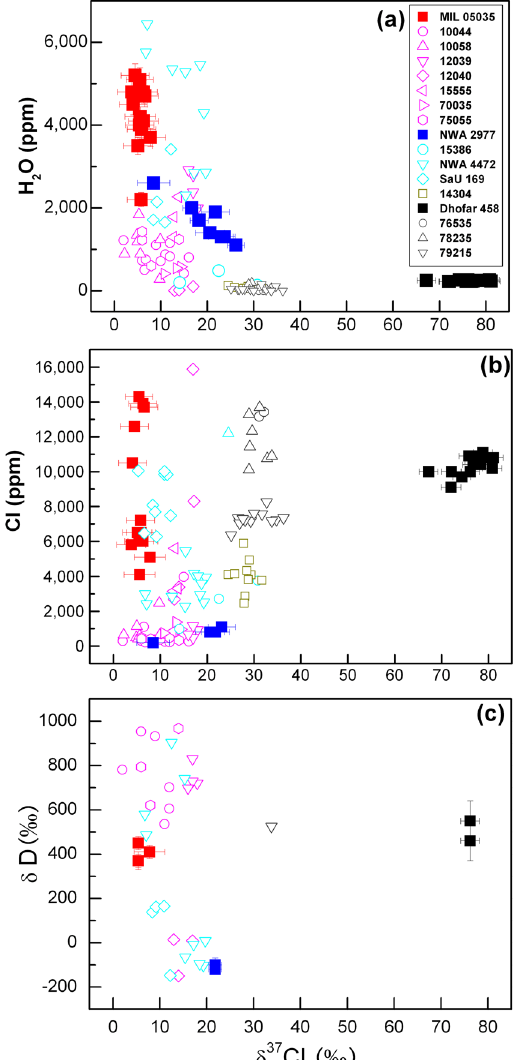
Figure 2. Plots of ( a ) H 2 O content, ( b ) Cl content, and ( c ) δ D versus δ 37 Cl for lunar apatite from MIL 05035, NWA 2977, and Dhofar 458. Data from the literature (hollow symbols) 8–12 are also plotted for comparison. Red and magenta symbols represent mare basalts; blue and cyan symbols are KREEP-bearing basalts; black and grey symbols are highland rocks; and 14304 is a very high-K basalt. No apparent correlation can be observed among δ 37 Cl, δ D, and Cl